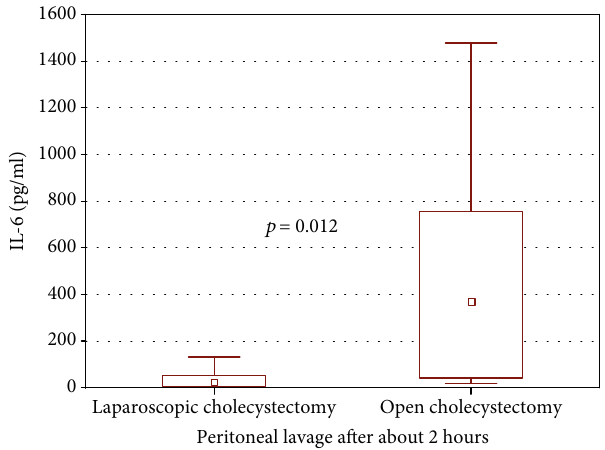
Figure 1: The comparison of IL-6 concentration in peritoneal lavage fl uid of children underwent cholecystectomy after about 2 hours from the beginning of the laparoscopic ( N = 12 ) compared to open procedure ( N = 10